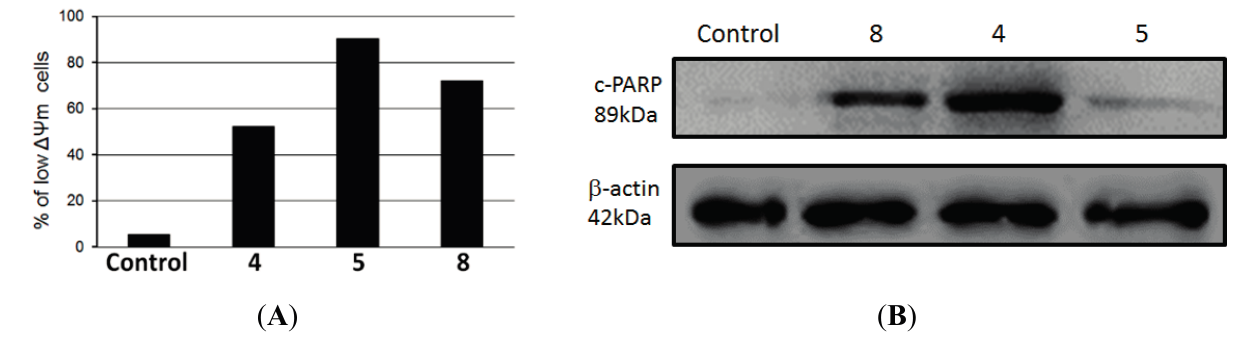
Figure 3. ( A ) Mitochondrial membrane depolarization induced by compounds 4 , 5 and 8 in HL-60 cells; ( B ) Lysates from HL-60 cells, previously treated with compounds 4 , 5 and 8 at 100 µg/mL for 24 h at 37 °C, were analyzed by Western blotting. Antibodies against cleavage PARP and β -actin (protein loading control) were